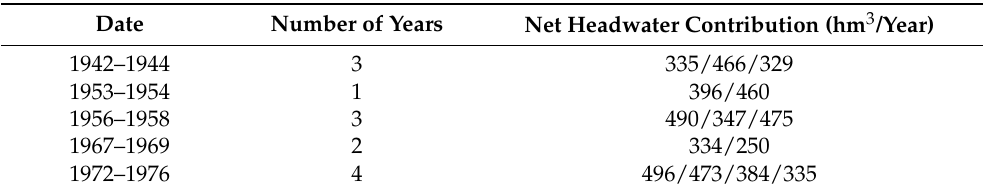
Table 3. Annual net headwater contributions for the droughts detected in the period 1940/41-1980/81. Source: SPD 2018 [34]. Own elaboration.